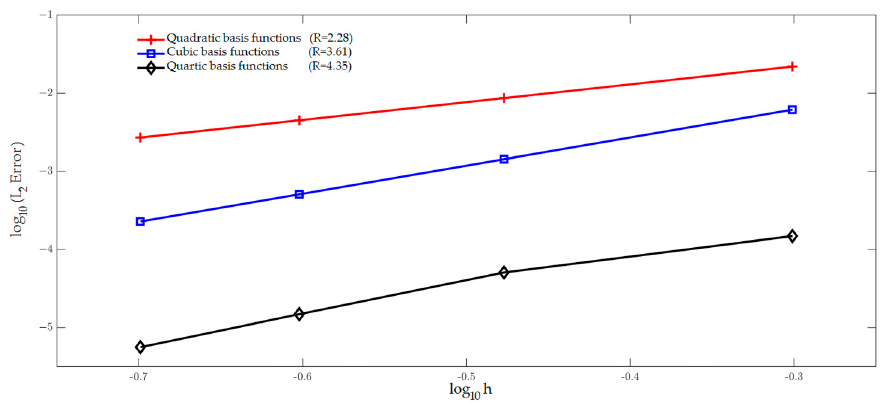
Figure 6. Convergence comparison with different number of the nodes and order of basis.